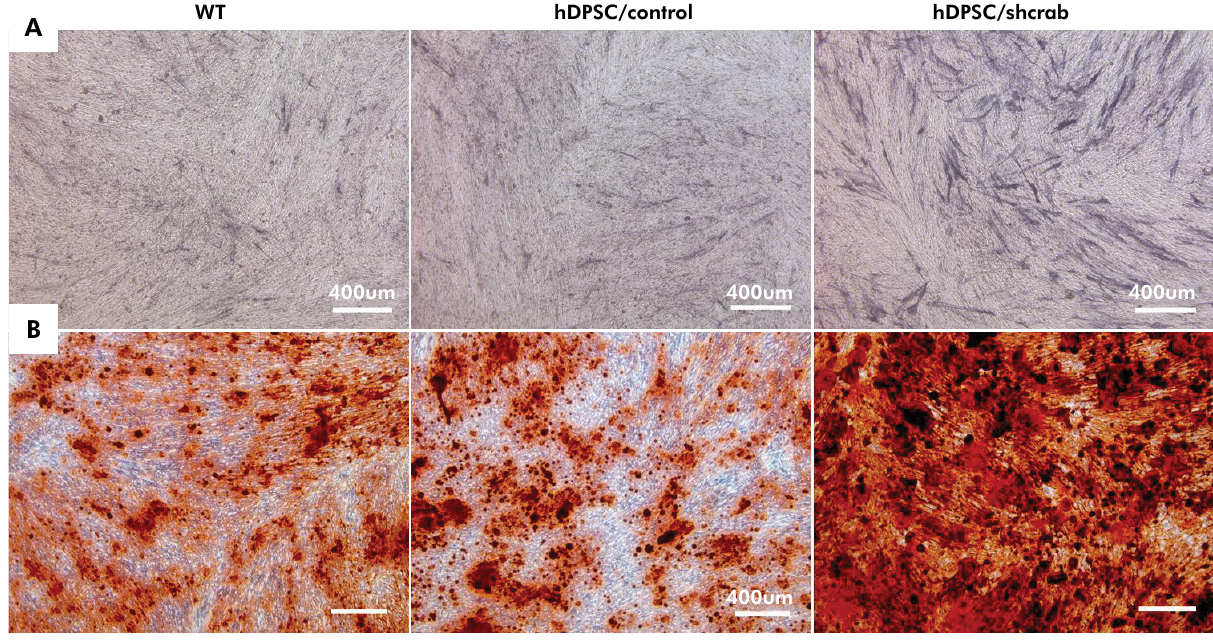
Figure 6. ALP staining and mineralized nodule formation. A: ALP staining was significantly higher in the hDPSC/shcrab group on day 7 compared with the wt and hDPSC/control groups. B: The number of mineralized nodules formed in the hDPSC/shcrab group was significantly higher compared with that in the wt and hDPSC/control groups (A and B: phase-contrast microscopy,